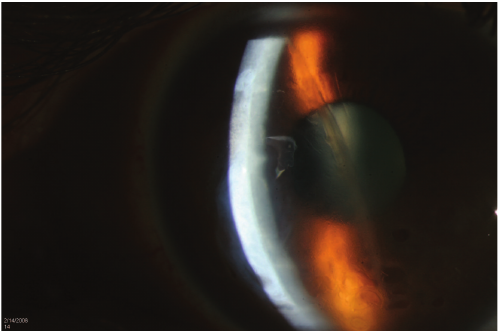
Figure 2: Slit lamp biomicroscopy photo at 1.5 years after DSAEK showing a nonedematous cornea with minimal superficial scarring.